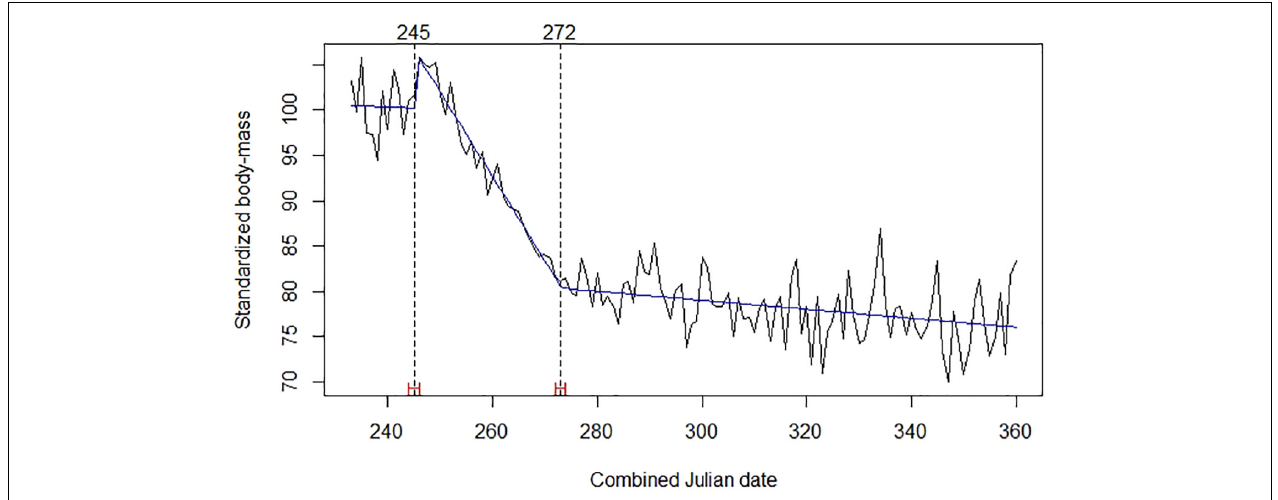
FIGURE 2 | Mean daily standardized body mass of red deer (black broken line), trends (blue line), Julian date of estimated structural changes (dashed lines, labeled at the top), and 95% confidence intervals of estimated structural change date (red bars). Table 1 provides details about sample size and origin of data.